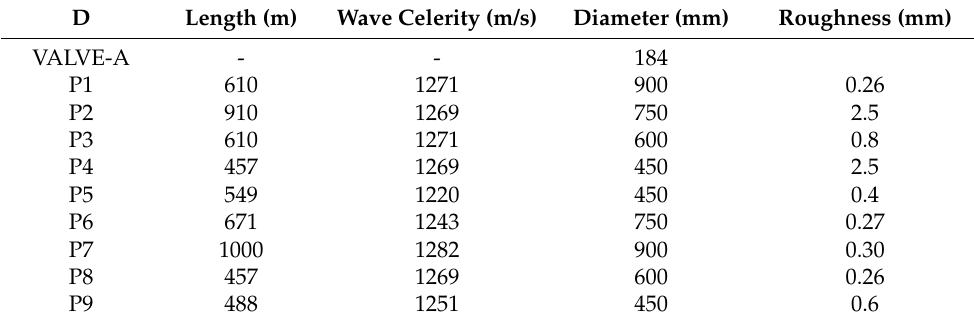
Figure 2. Benchmark network structure. Table 5. Properties of the benchmark network.